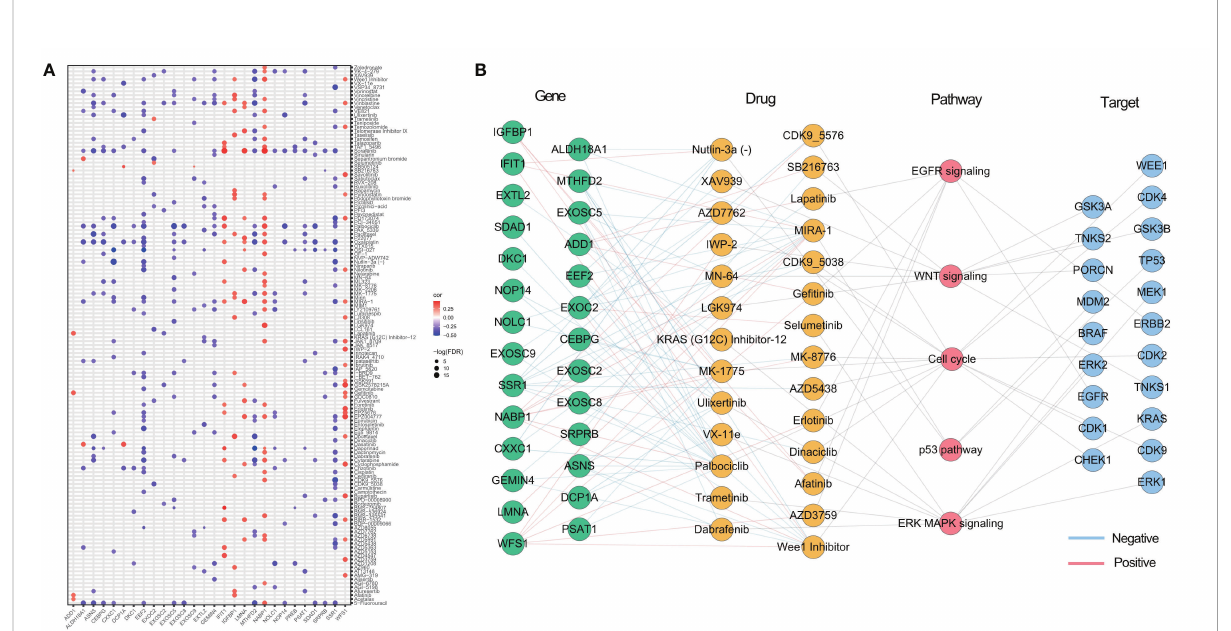
FIGURE 7 Potential therapeutic effects of ER stress factors. (A) The correlation between drug sensitivity and autophagy regulatory factors, and the demonstrated autophagy regulatory factors were correlated with at least fi ve drugs; (B) Drugs targeting EGFR, WNT, p53, Cell cycl, ERK MAPK signaling pathways, the targets of these drugs, and the endoplasmic reticulum stress factors related to these